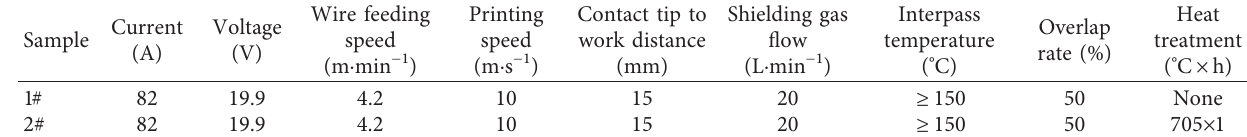
Table 2: Wire arc additive manufacturing parameters.